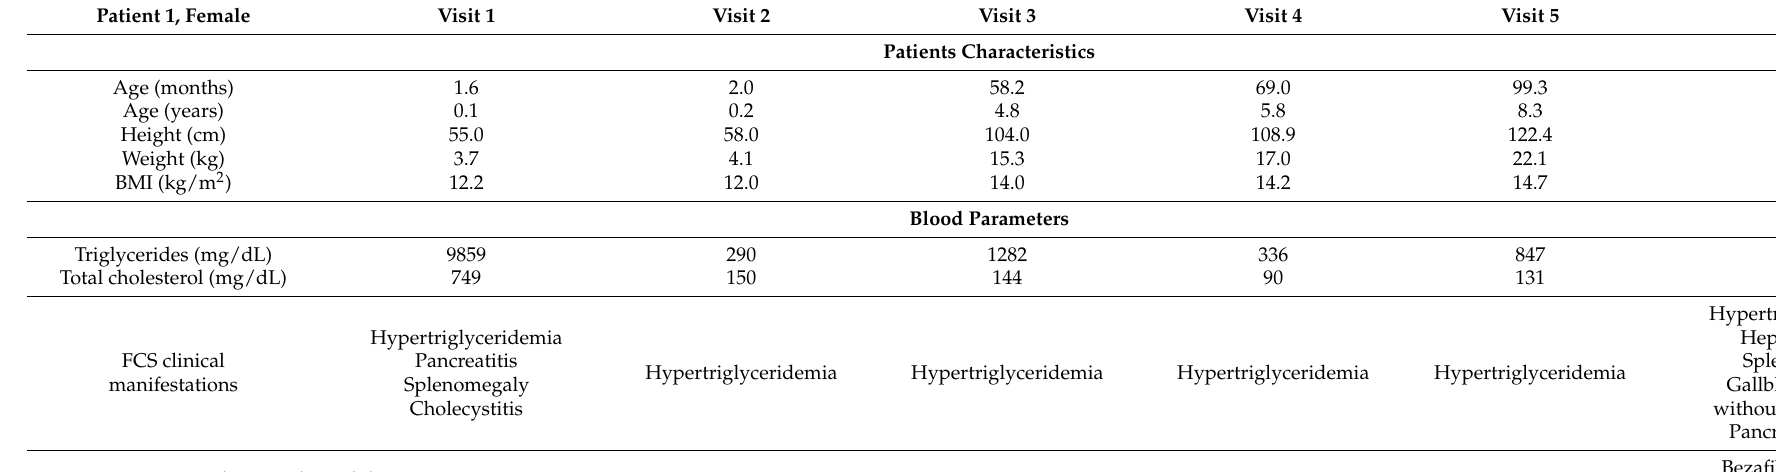
Table 3. Patient 1—blood parameters and nutrients